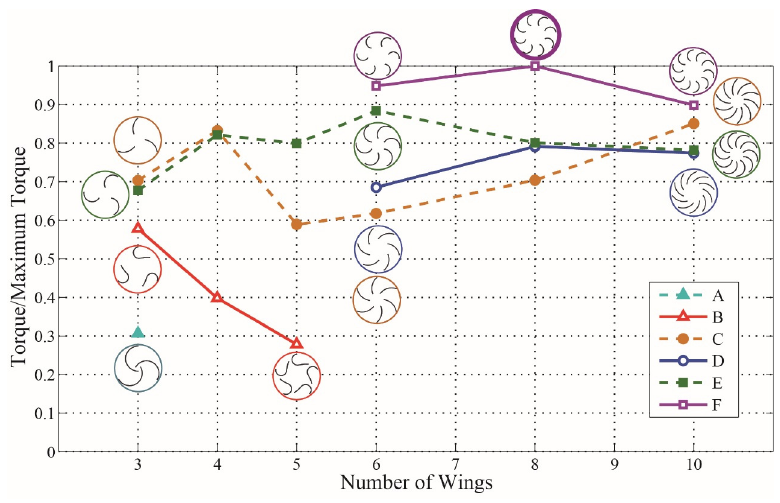
Figure 12. Average torque values generated on the center of the